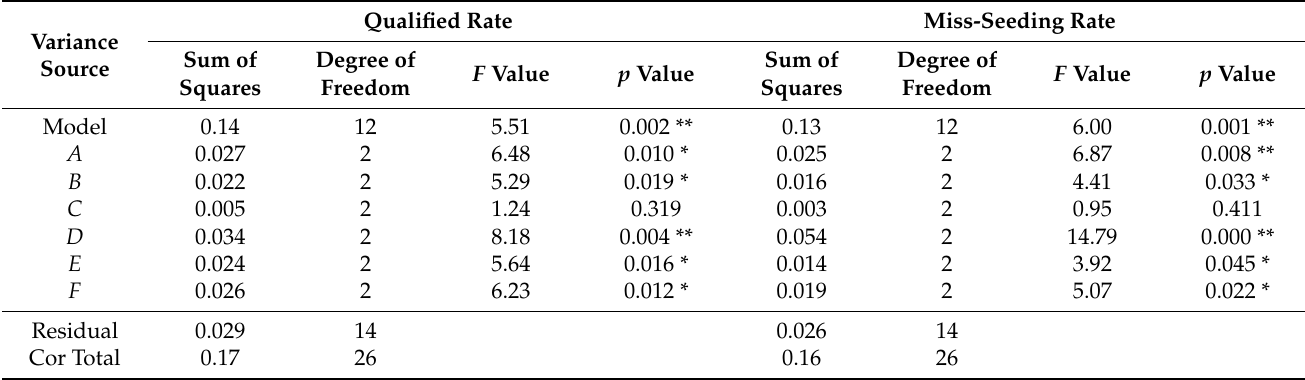
Table 3. Variance analysis of simulation